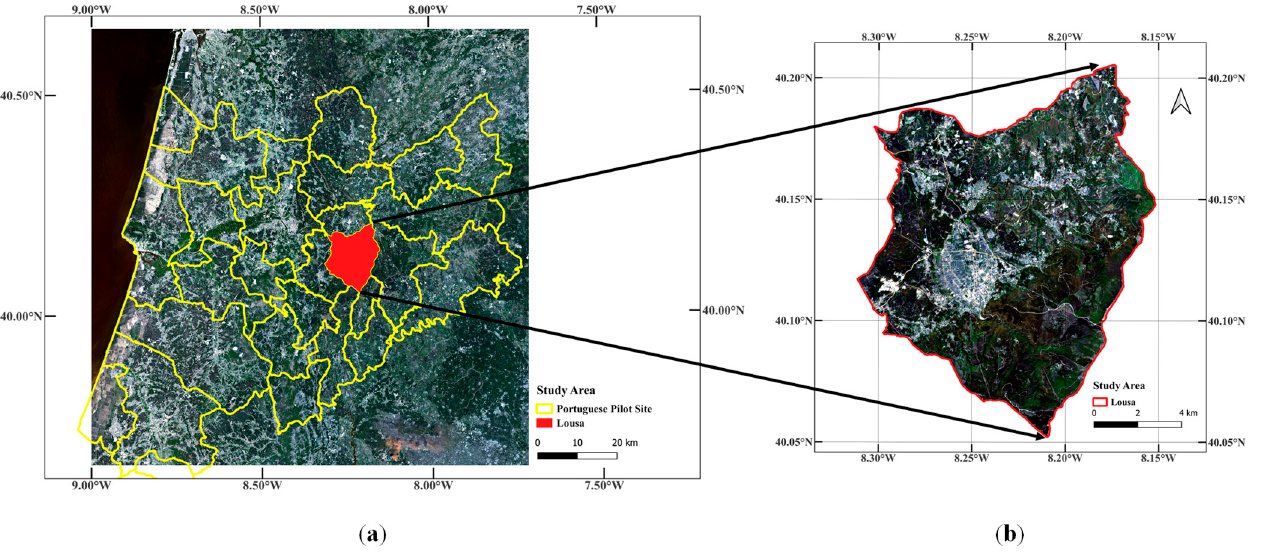
Figure 1. Geographical framework of the location and limits of the study area within a FirEUrisk project and mainland Portugal: ( a ) Sentinel-2 false-color composite image; ( b ) study area—Lousã.